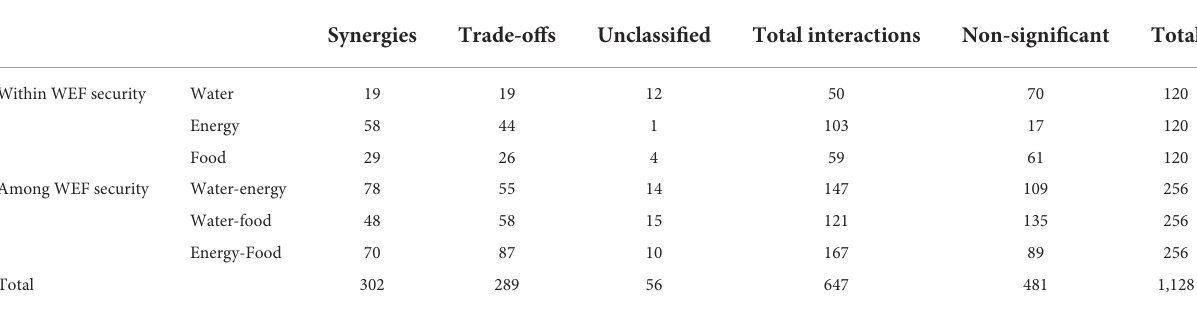
TABLE 2 Number of WEF interactions in Figure 1. Synergies Trade-offs Unclassified Total interactions